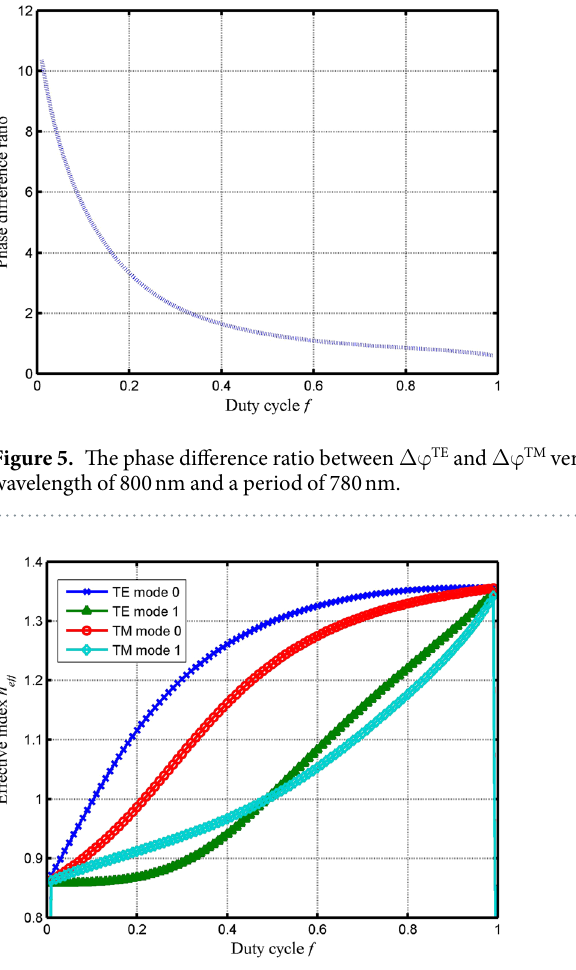
Figure 6. Effective index versus the grating duty cycle under the Littrow mounting.